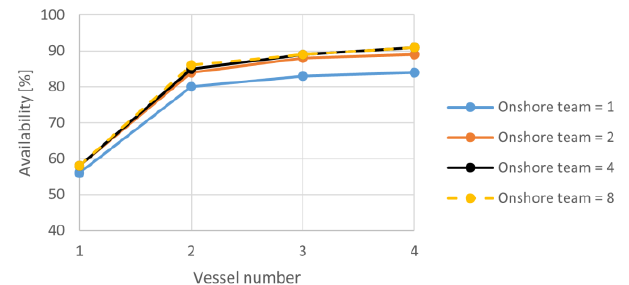
Fig. 18. Farm availability versus vessel number for various numbers of onshore teams, in the case of c/d time=1.5 hr and assembly team=3.